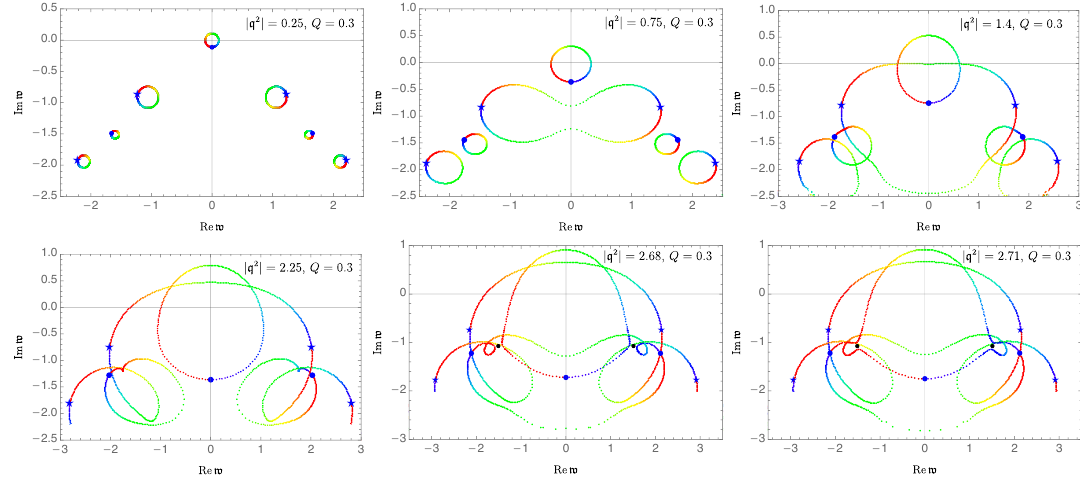
Figure 12. Poles of the retarded two-point function in the spin 1 channel at Q = 0 : 3, in the complex w (cid:0) plane, at various values of the complexi(cid:12)ed momentum q 2 = j q 2 j e i(cid:18) . Large dots and large stars correspond to the poles with purely real momentum (i.e. at (cid:18) = 0). As (cid:18) increases from 0 to 2 (cid:25) , each pole moves counter-clockwise following the trajectory whose color changes continuously from blue to red. At j q 2 j = 0 : 25 (top left panel) all poles follow closed orbits. By increasing j q 2 j , (cid:12)rstly the two lowest star gapped poles collide. After the collision, for instance at j q 2 j = 0 : 75 (top middle panel) their orbits are no longer closed; they exchange their positions cyclically as the phase (cid:18) increases from 0 to 2 (cid:25) . At j q 2 j = 1 : 4 (top right panel), the orbits of dot poles are still closed. By further increasing j q 2 j , the trajectory of shear pole comes close to those of nearest dot gapped poles; at j q 2 j = 2 : 69, they nearly collide at the positions marked by black dots (bottom middle panel). Just after the collision, at j q 2 j = 2 : 71 (bottom right panel) the orbits of shear pole and the two lowest dot gapped pole are no longer closed; three of them exchange their positions cyclically as (cid:18) increases from 0 to 2 (cid:25) . This is the manifestation of (cid:22) T (cid:22) T (cid:0)